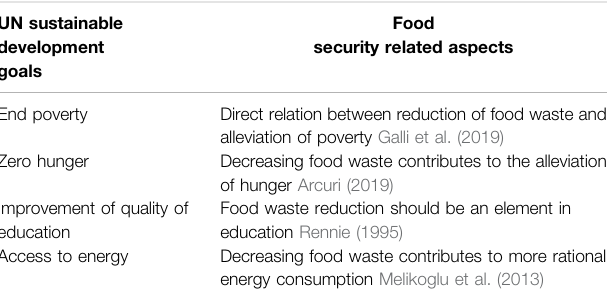
TABLE 1 | Interactions between UN Sustainable Development Goals and food security. UN sustainable